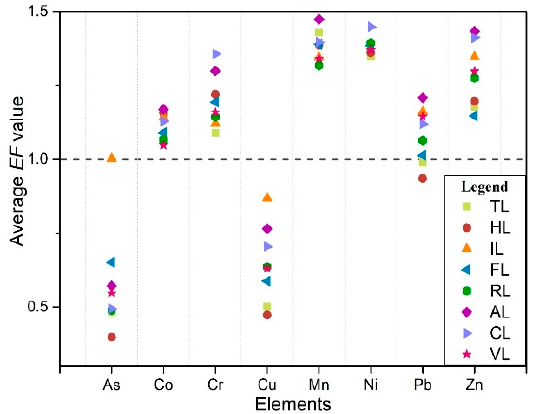
Figure 5. Scatter of average enrichment factors ( EFs ) for PHEs under different land-use types.